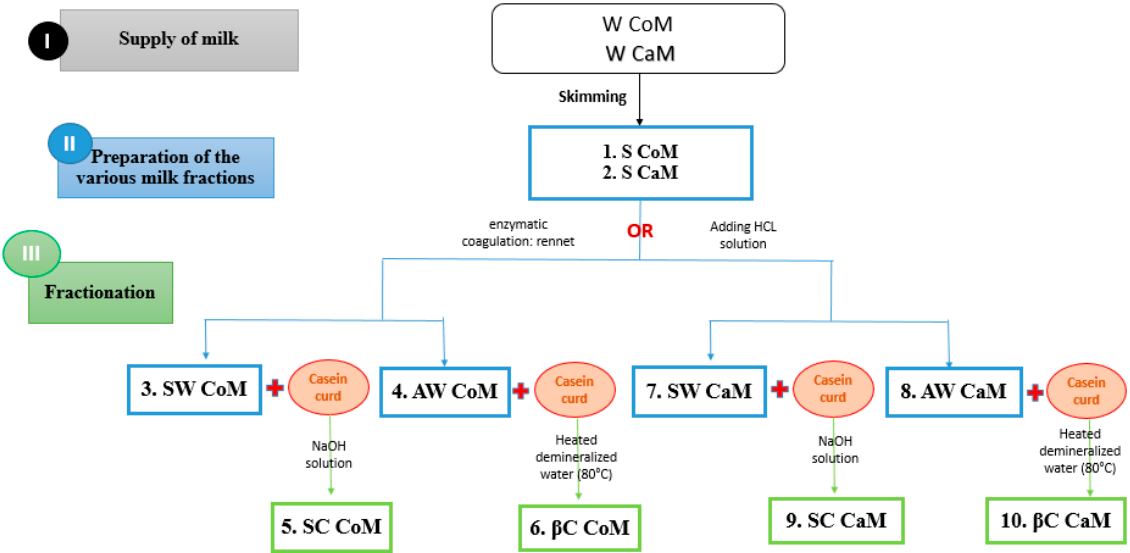
Figure 1. Scheme of milk fractionation by acid, and enzymatic coagulation and centrifugation. CoM: cow milk; W CoM: whole cow milk; S CoM: skim cow milk; AW CoM: acid whey from cow milk; SW CoM: sweet whey from cow milk; SC CoM: sodium caseinate, from cow milk; β C CoM: β -casein from cow milk; W CaM: whole camel milk; S CaM: skim camel milk; AW CaM: acid whey from camel milk; SW CaM: sweet whey from camel milk; SC CaM: sodium caseinate, from camel milk; β C CaM: β -casein from camel